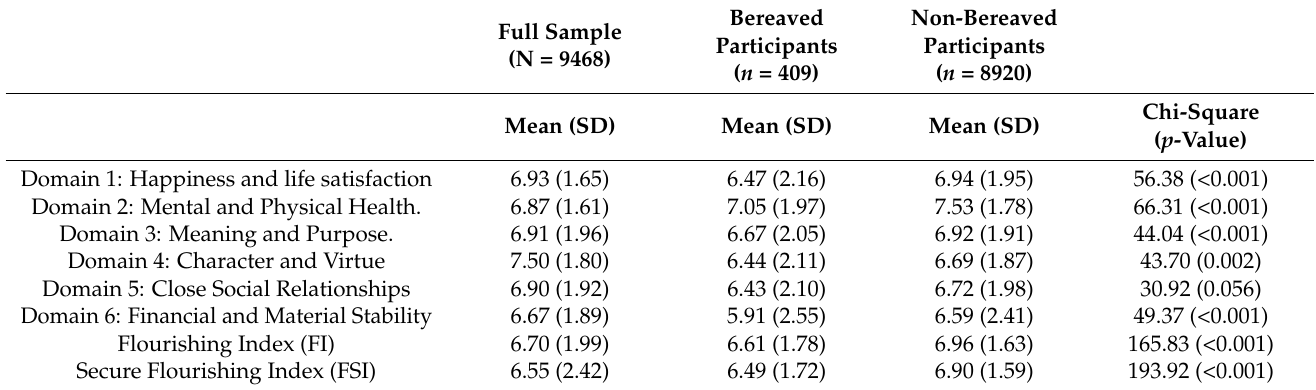
Table 4. Adulthood flourishing by self-reported childhood bereavement